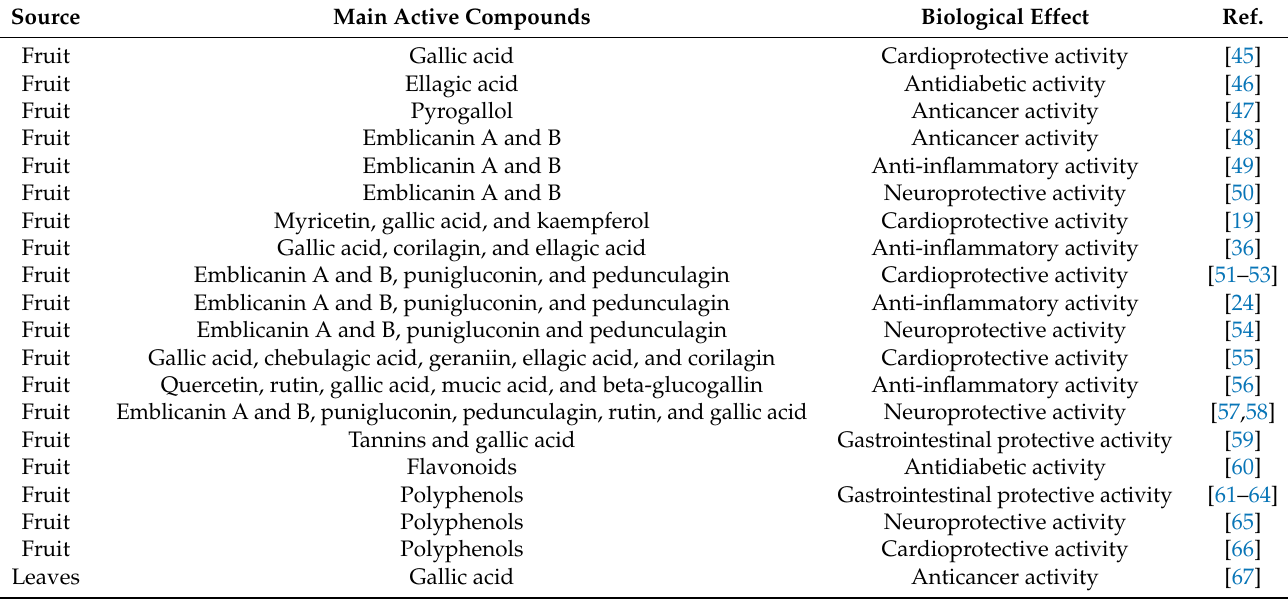
Table 3. Amla polyphenols and their biological effects beyond antioxidant